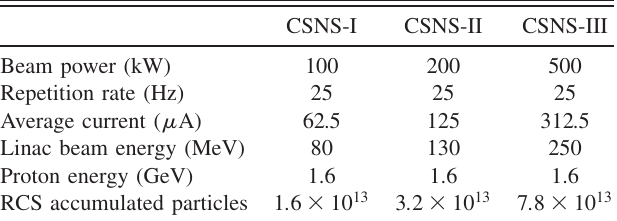
TABLE VII. Main parameters of CSNS.